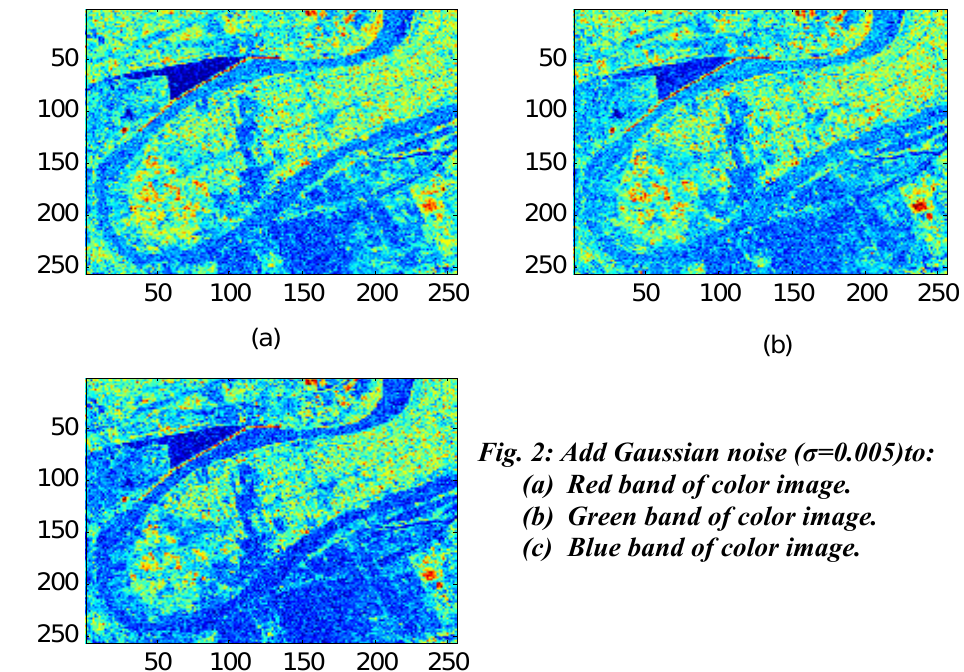
Fig. 2: Add Gaussian noise ( σ =0.005)to: (a) Red band of color image. (b) Green band of color image. (c) Blue band of color image.